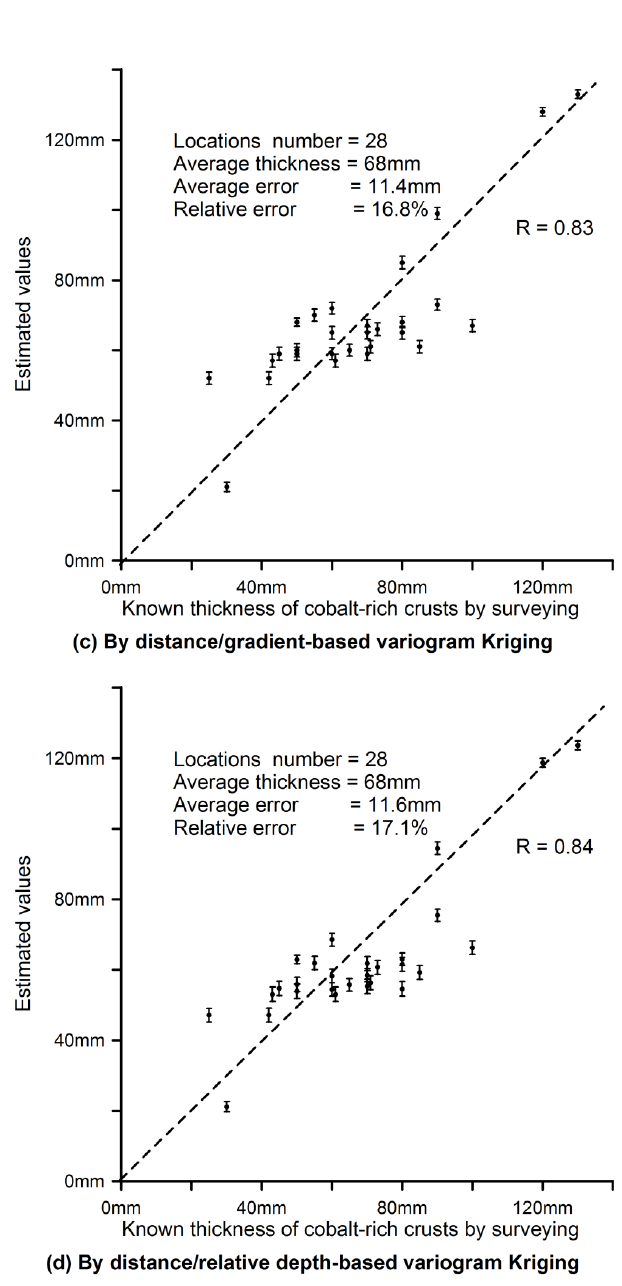
Figure 9. Cobalt-rich crust thicknesses known and estimated at the 28 survey locations with four different interpolation methods. Estimated error variance of each point is annotated by vertical error bar. The average error, relative error, and correlation coefficient R between the two sets of values are indicated.